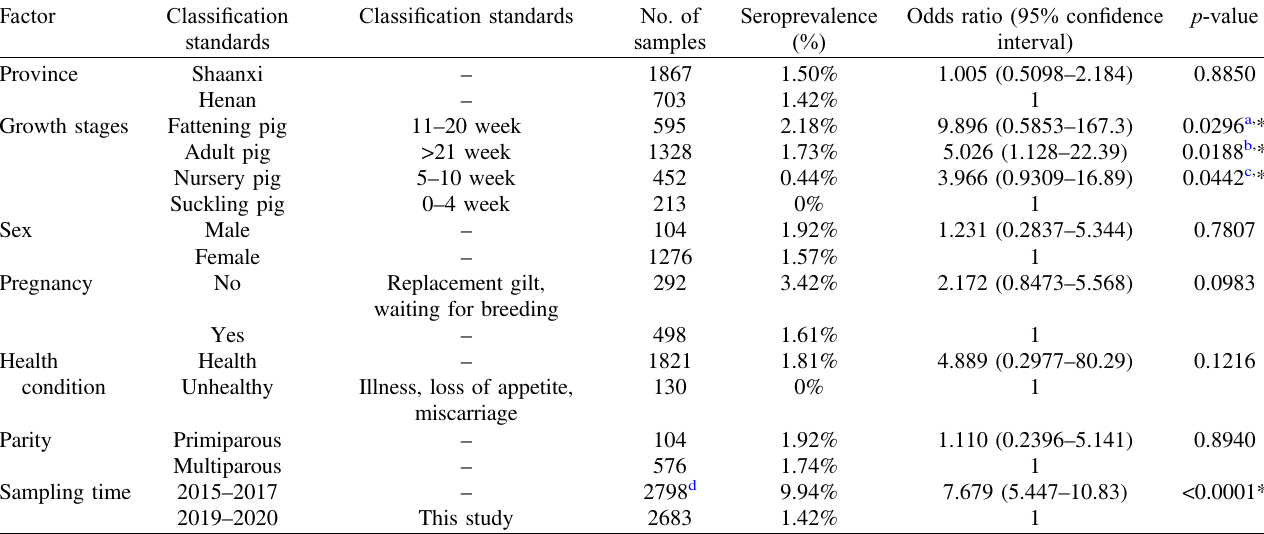
Table 2. Seroprevalence and risk factors for Toxoplasma gondii in swine tested by modi fi ed agglutination